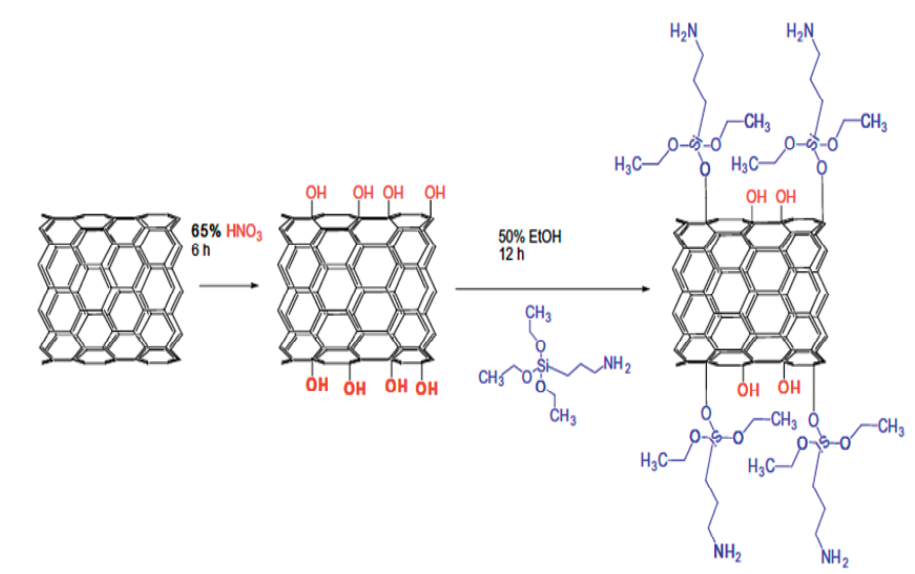
Figure 5. A schematic representation of the chemical functionalization of BNNT surface with 3-aminopropyltriethoxysilane (APTES) molecules. Reprinted with permission from [115]; © 2012 Elsevier